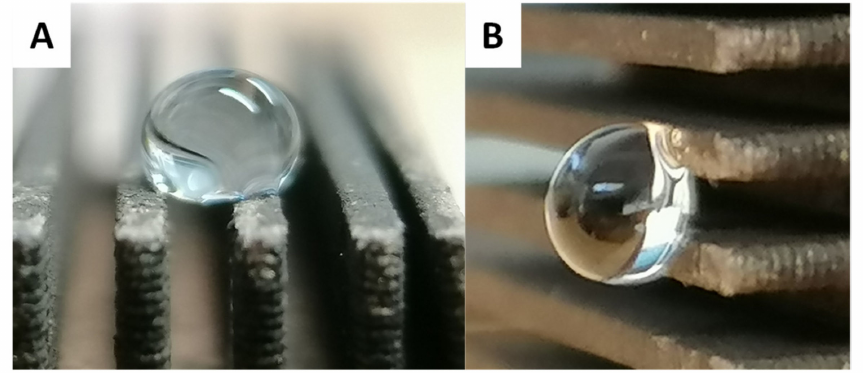
Figure 11. Example of water drop on PVB C 14 . ( A ) On horizontal surface and ( B ) On vertical surface (inclination of 90 ◦